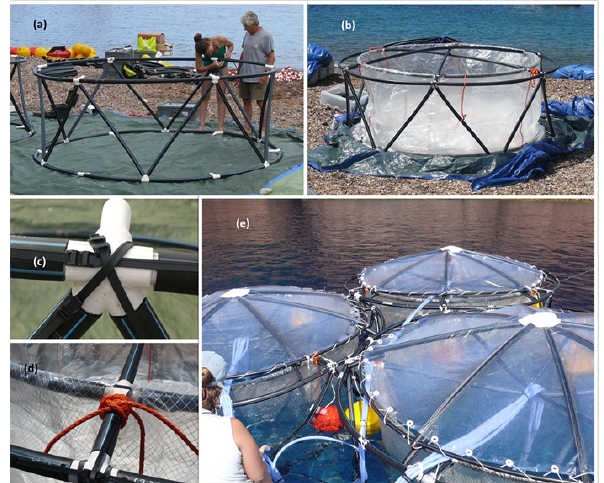
Fig. 5. Details of the mesocosm structure before (a) and after (b) installing the bag inside; (c) and (d) , detailed view of the connec- tions showing how the bag is fixed to the structure; (e) transparent covers above the bags and structures allowing the air to pass – this picture also shows the sampling tubes that allow for sampling from outside without introducing any other device into the inside of the water body (photos: DUNE Team and D. Luquet OOV).